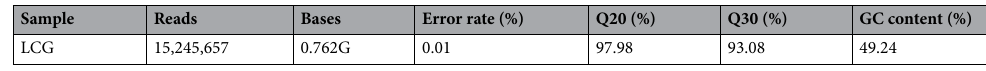
Table 2. Sequence statistics and quality control of